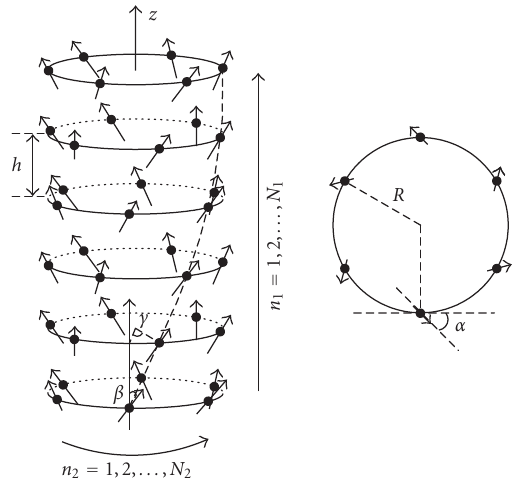
Figure 2: Cylindrical aggregate consisting of a stack of N 1 rings, labeled n 1 = 1,2, ... , N 1 , such that each contains N 2 molecules la- beled n 2 = 1,2, ... , N 2 . The arrows indicate the transition dipoles. Each ring is rotated with respect to the previous one over an angle γ , giving rise to a helical